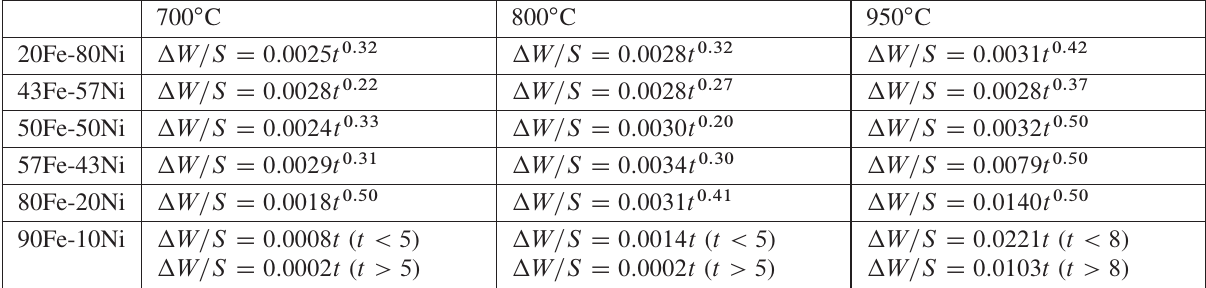
Table 1. Oxidation kinetic curve equations of Fe-Ni alloys at 700 ı C, 800 ı C and 950 ı C. Weight gain ( (cid:2)W=S , g = cm 2 / vs. time ( t , h ).